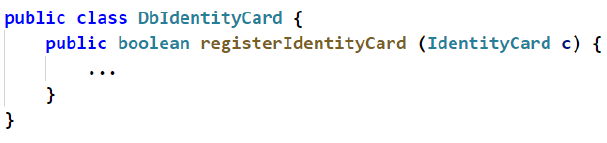
Figure 3. An example of parameter type information of a code feature.